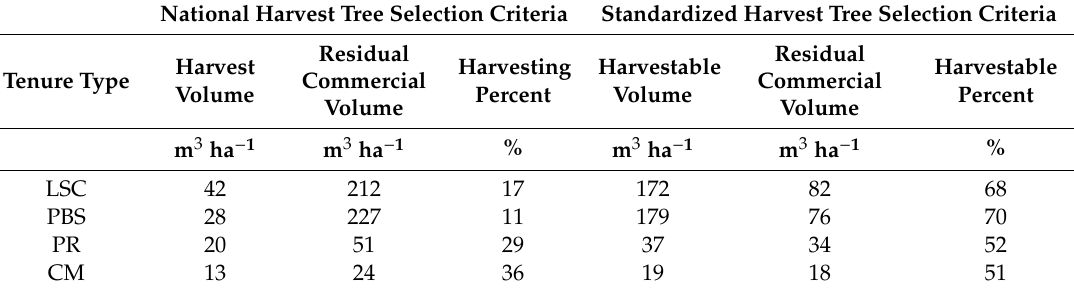
Table 6. Mean harvest intensities per forest tenure type Figure 8. DBH-histogram of national harvest tree selection and commercial residual stand of trees National Harvest Tree Selection Criteria Standardized Harvest Tree Selection with LG 1 & 2.